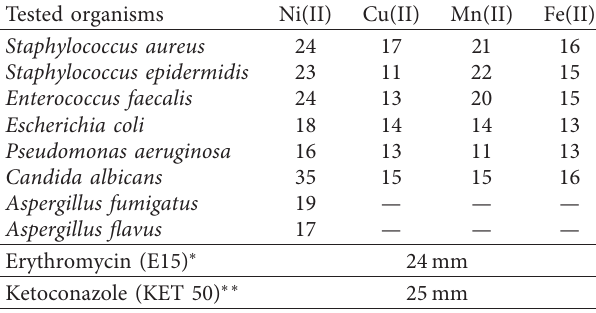
Table 8: Microbiological screening of the complexes. Tested